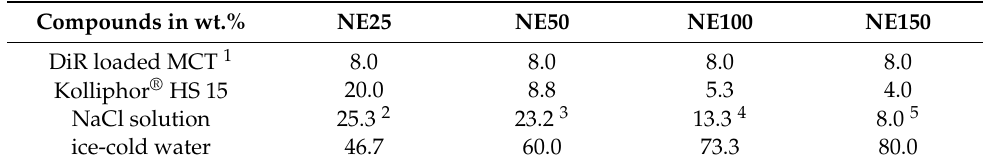
Table 1. Composition of the isotonic nanoemulsions. Compounds in wt.%